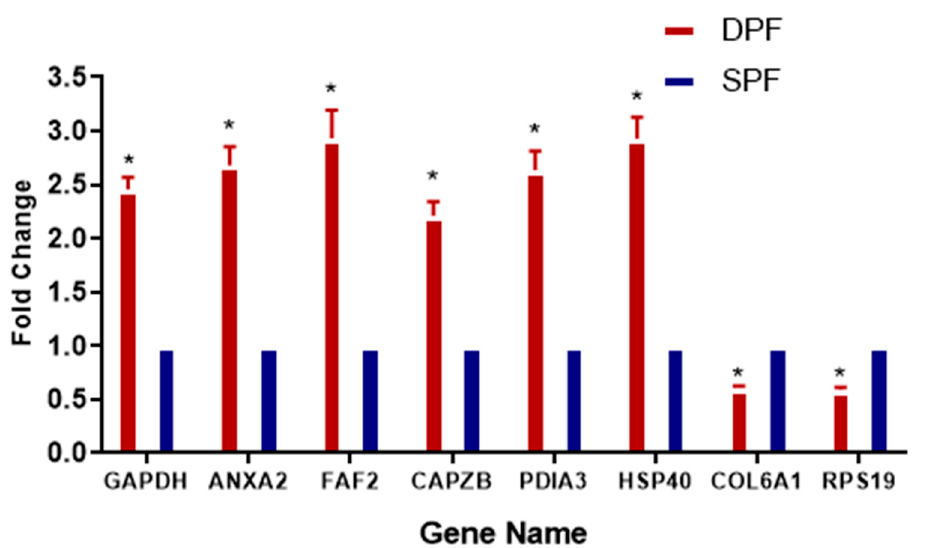
Figure 7. Verification of relative gene expression levels of Gapdh , Anxa2 , Faf2 , Capzb , Pdia3, and Hsp40 and downregulated as Col6a1 , and Rps19 by using real-time qPCR analysis. The data are expressed as mean ± SD; and statistical significance: p < 0.05. The β -actin gene expression was used as a reference gene. Asterisk (*) indicates the statistical difference ( p < 0.05) between the groups. SPFs and DPFs: Small and developing primary follicles